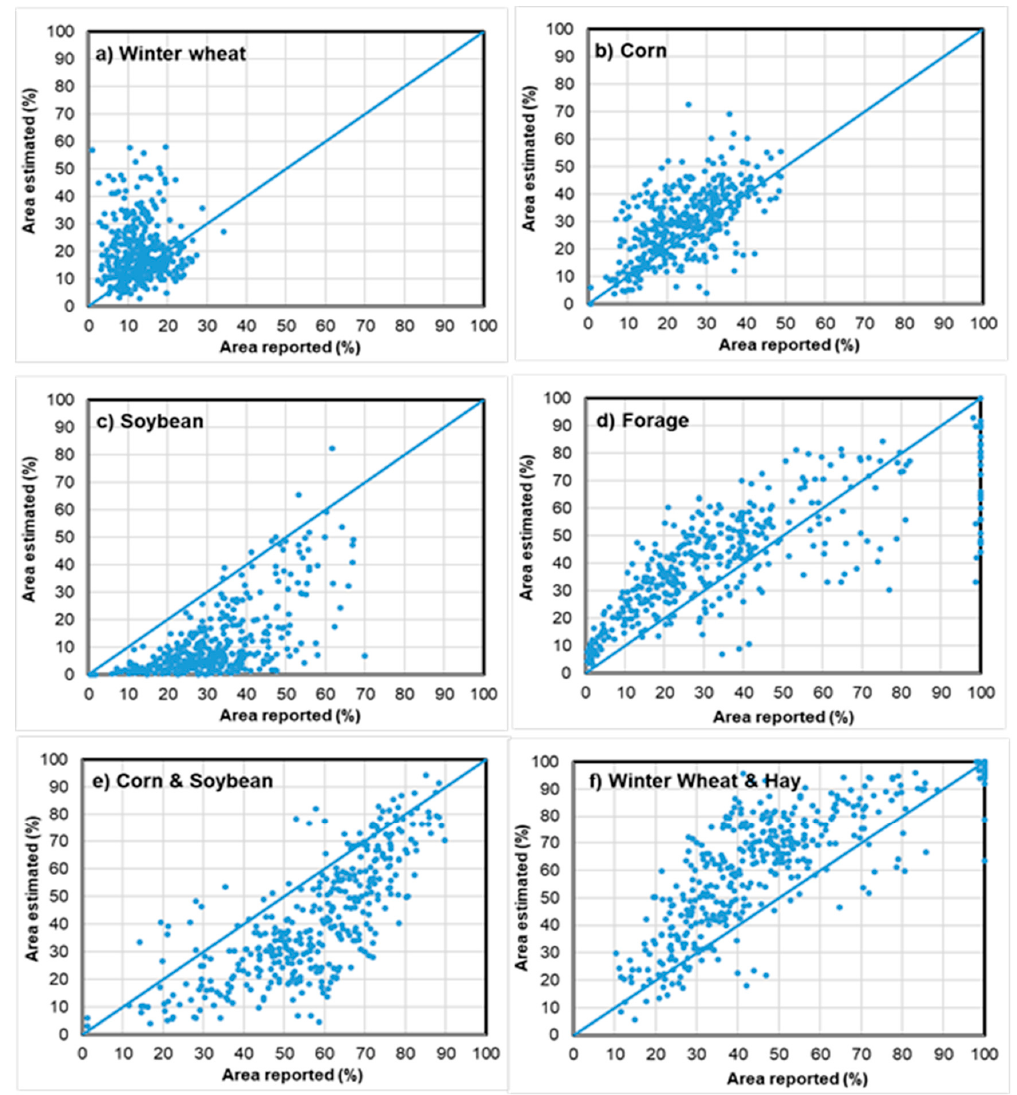
Figure 2. Comparison of county level crop area proportions estimated annually using the fuzzy decision tree classifier and reported by the Ontario Ministry of Agriculture, Food and Rural Affairs (OMAFRA) for the period between 2003 and 2016.